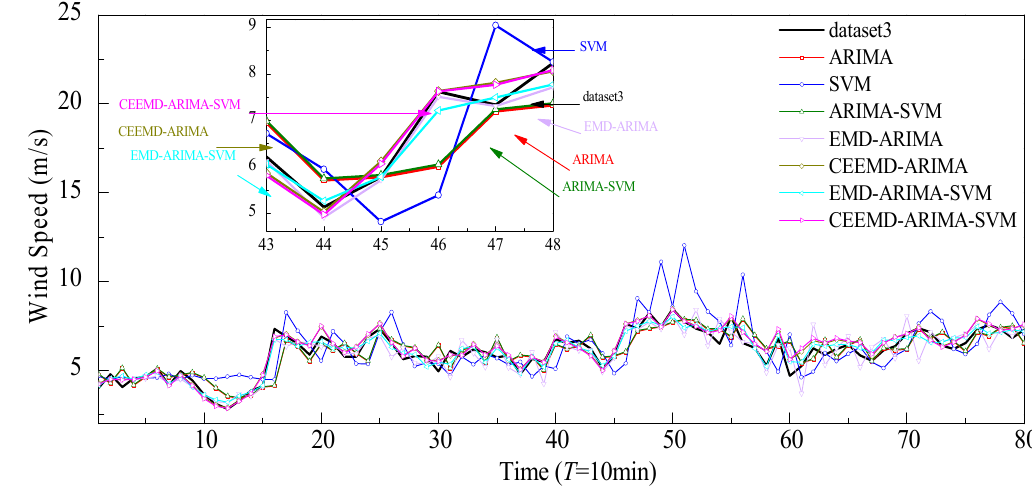
Figure 8. Comparative prediction results for dataset 3.